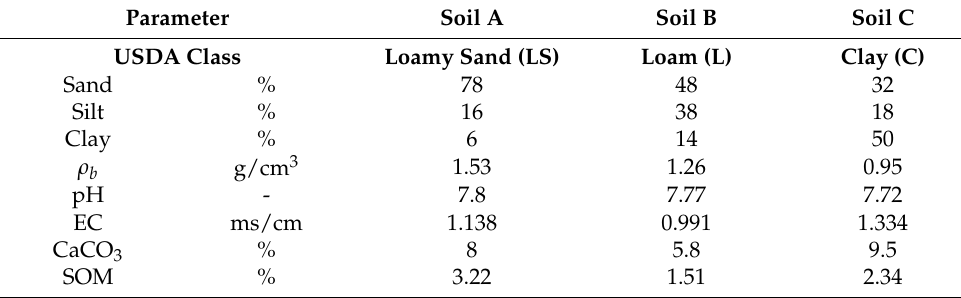
Table 1. Characteristics of the three soils used in this study.